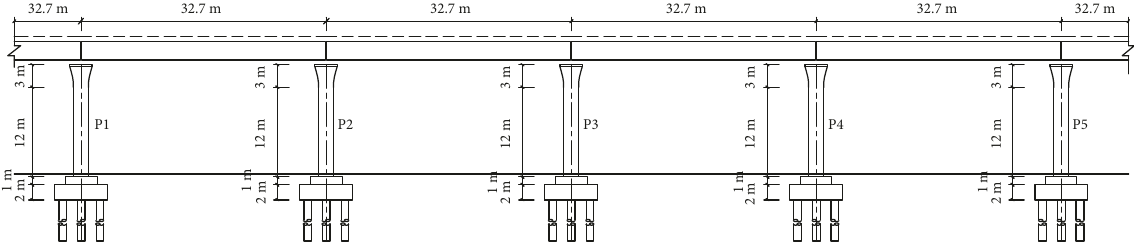
Figure 2: Longitudinal section of a multi-span simply-supported beam.